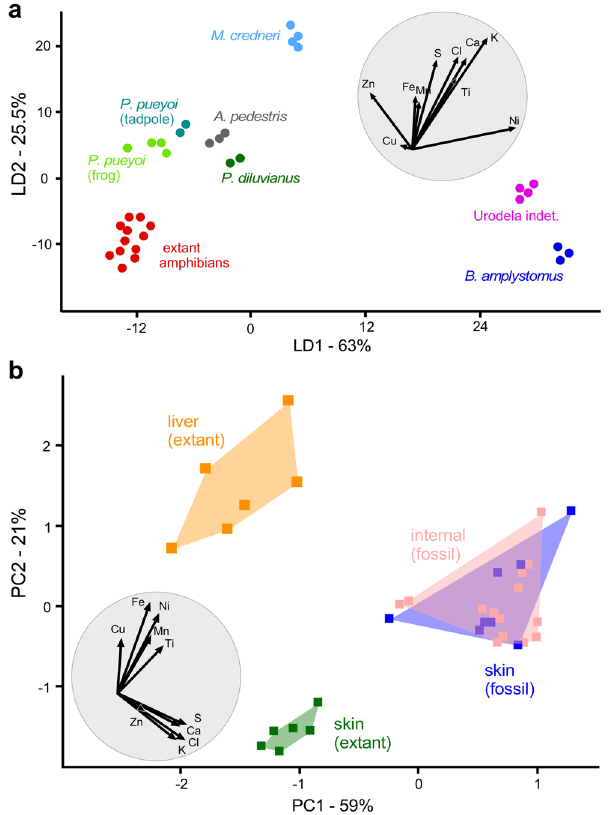
Figure 4. Multivariate analysis of the inorganic chemistry of modern and fossil melanosomes from amphibian tissues. ( a ) Linear Discriminant Analysis (LDA) of extant and fossil species. ( b ) Principal Component Analysis (PCA) of the inorganic chemistry of melanosomes from skin and liver. Grey circles are biplots. Note extensive overlap of the data for these two tissues in fossil amphibians